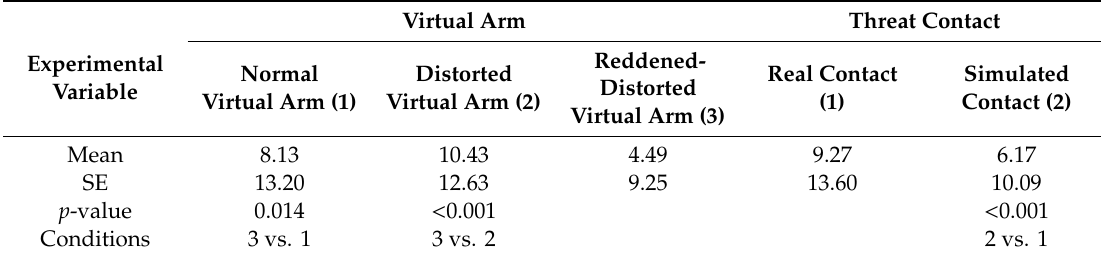
Table 1. Values in terms of means, standard error (SE), and p -values indicating mean di ff erences between the di ff erent experimental